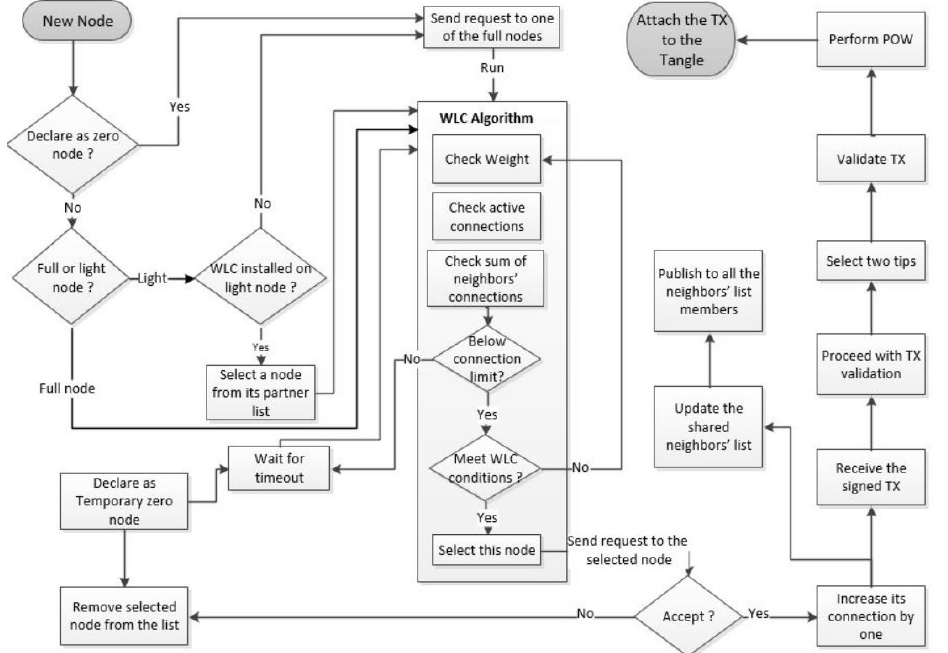
Figure 4. Flowchart diagram of the proposed